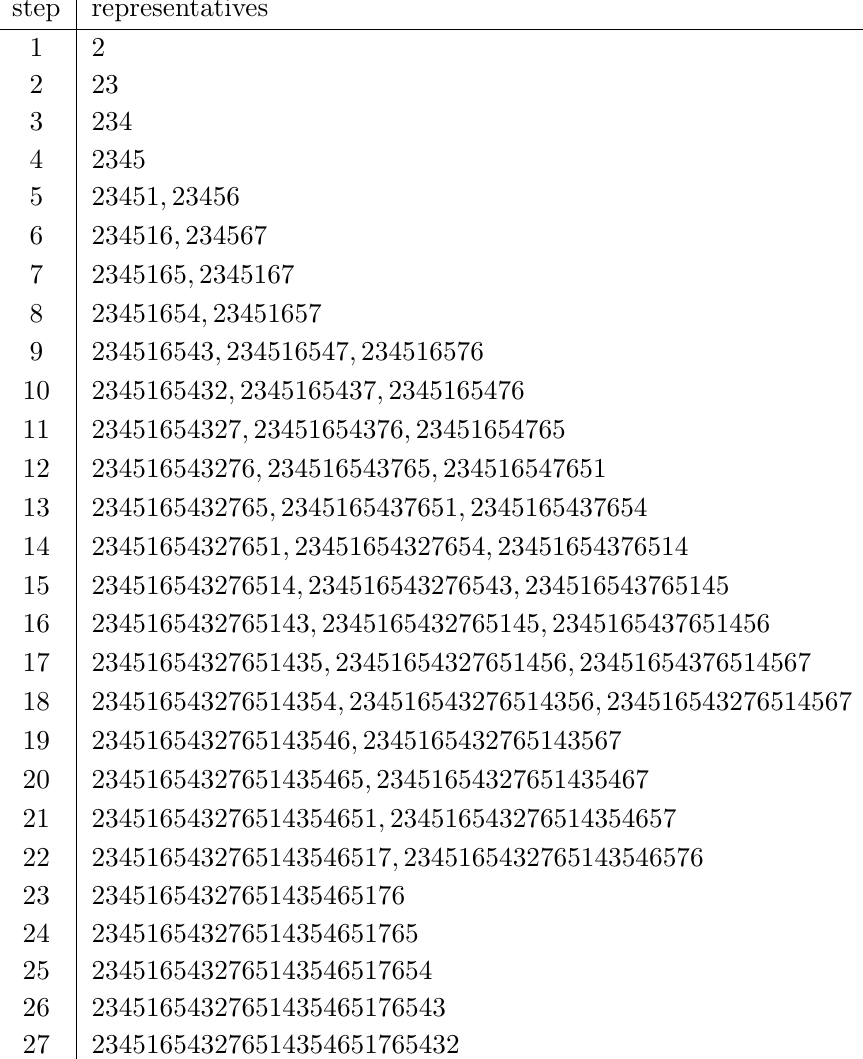
Table 7 . The 56 cosets of the E 6 Weyl group (generated by s 1 ; s 3 ; s 4 ; s 5 ; s 6 ; s 7 ) in the E 7 Weyl group (generated by s 1 ; s 2 ; s 3 ; s 4 ; s 5 ; s 6 ; s 7 ). We abbreviate s 1 ; s 2 ; s 3 ; s 4 ; s 5 ; s 6 ; s 7 as 1 ; 2 ; 3 ; 4 ; 5 ; 6 ; 7 for